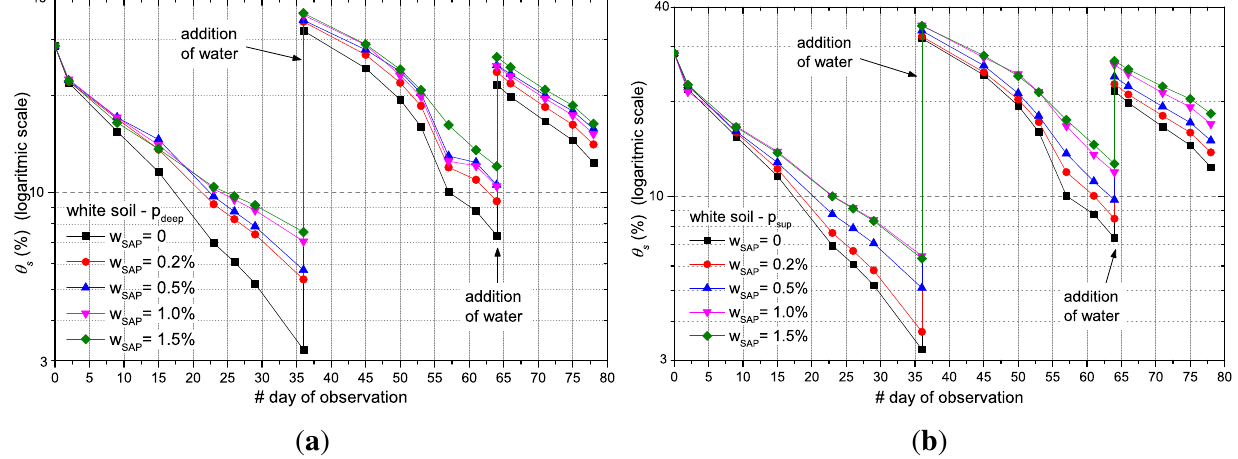
Figure 5. Variation of the moisture content of the white soil during the 78-day observation time: for p ( a ) and p ( b ) samples, with different percentages of deep sup